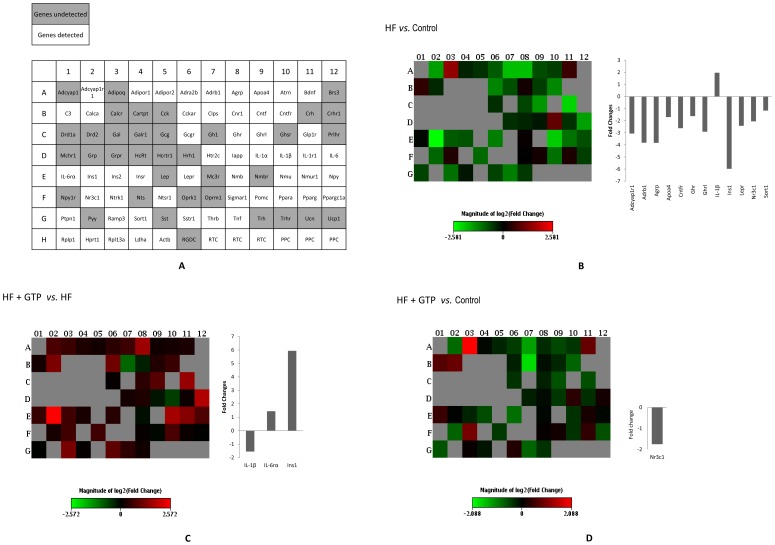
The changes of obesity-related genes among the control, HF, and HF+GTP groups.(A) Representative PCR array gene tables of undetected genes and detected genes. (B) The heat map demonstrating fold regulation expression data between the HF group and the control group. Genes with significant differences between two groups are shown in the histogram. (C) The heat map demonstrating fold regulation expression data between the HF+GTP group and the HF group. Genes with significant differences between two groups are shown in the histogram. (D) The heat map demonstrating fold regulation expression data between the HF+GTP group and the control group. Genes with significant differences between two groups are shown in the histogram.